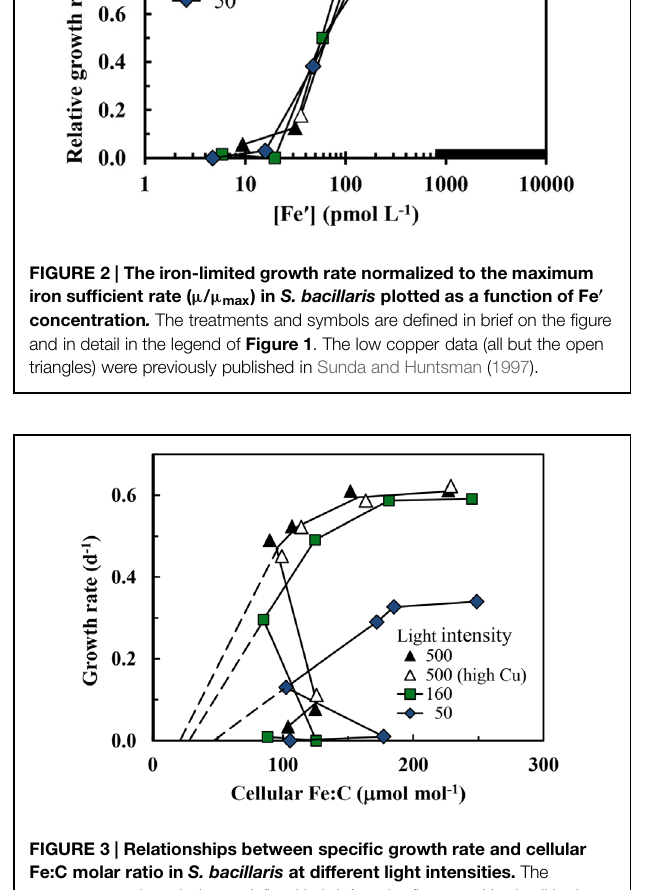
FIGURE 5 | Relationships between cellular Chl a :C ratio and specific growth rate in iron-limited and iron-sufficient cells grown at the three light intensities: 500, 160, and 50 µ mol quanta m − 2 s − 1 . The treatments and symbols are defined in brief on the figure and in detail in the legend of Figure 1